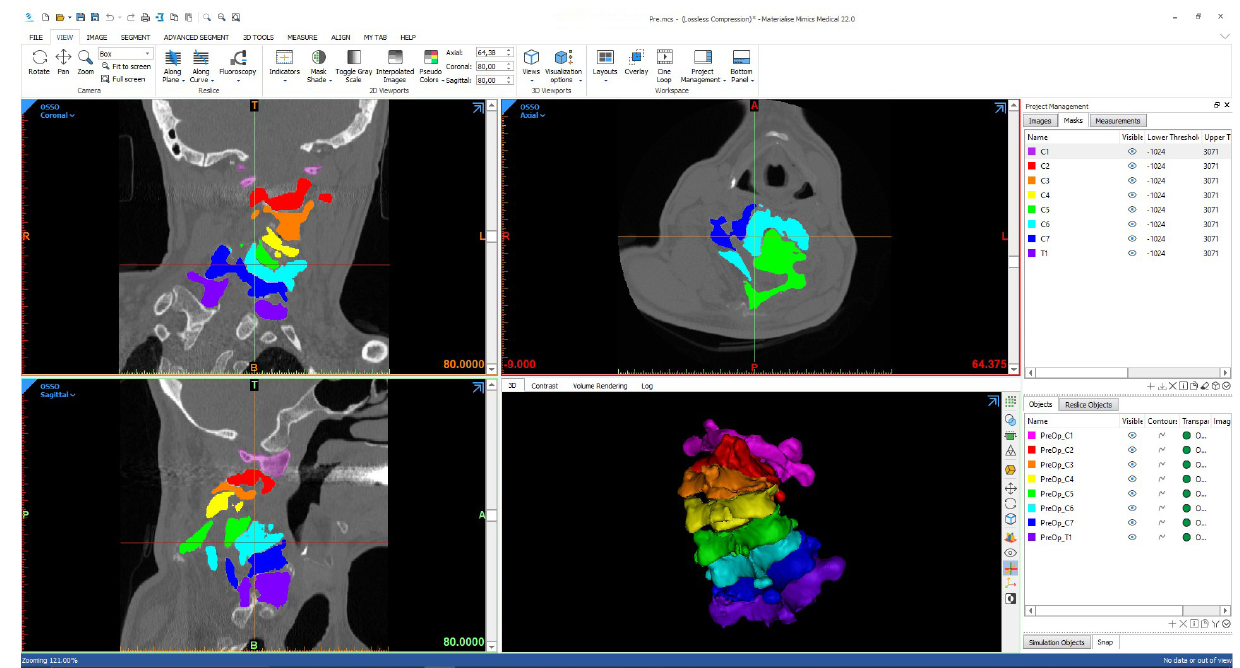
Figure 3. Screenshot from the segmentation software. The C1-to-T1 vertebrae were segmented independently of each other to obtain eight different 3D bone models. These can also be merged into a single model after an easy aggregation process.